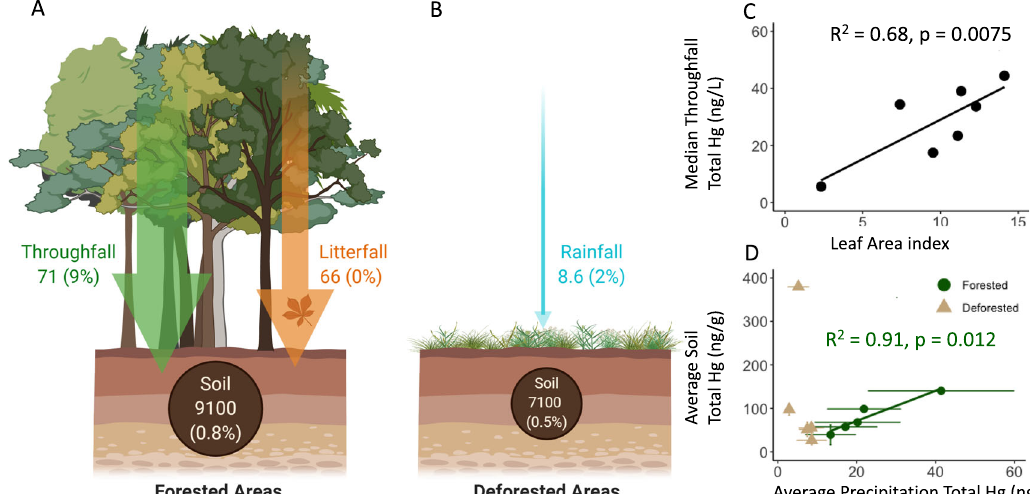
Fig. 3 Mercury fl ux and sur fi cial soil pools (0 – 5 cm) at the Los Amigos Conservation Concession. Data are shown in A forested and B deforested areas. The deforested area at Los Amigos represents a clearing for the fi eld station, which makes up a small fraction of total land. Fluxes are shown in arrows and expressed as µ g m − 2 yr − 1 . Pools are shown in circles for the top 0 – 5 cm of soil and expressed as μ g m − 2 . Percentages represent the percent of the mercury present as methylmercury in the pool or fl ux. The average concentration between the dry season (2018 and 2019) and wet season (2018) for total mercury in throughfall, bulk precipitation, and litterfall were used for this upscaled estimate of mercury loading. Methylmercury data are based on the 2018 dry season, the only year that it was measured. For information on pool and fl ux calculations, see the “ Methods ” . C Relationship between total mercury concentration in throughfall and leaf area index at the eight plots at Los Amigos Conservation Concession according to an ordinary least square regression. D Relationship between precipitation total mercury concentration and sur fi cial soil mercury total concentration at all fi ve sites in the forested (green circle) and deforested (brown triangle) areas according to an ordinary least square regression (error bars show standard